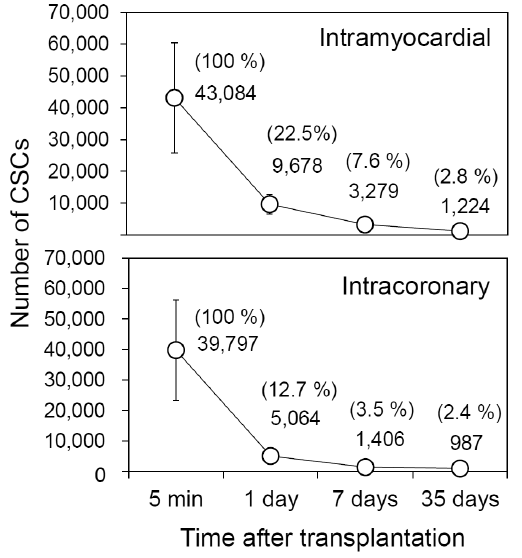
Figure 4. Comparison of CSC retention and engraftment after intramyocardial and intracoronary delivery. Female mice with acute MI were given 10 5 c-kit + /lin- male murine CSCs by the intramyocardial [23] (upper panel) or intracoronary (present study; lower panel) route. The data shown in the top panel are reproduced from our previous paper [23]. The absolute numbers of CSCs detected in the entire heart at indicated time points are shown. The number of cells found at each time point, expressed as a percentage of the cells found at 5 min after delivery, is shown in the parenthesis. Data are means 6